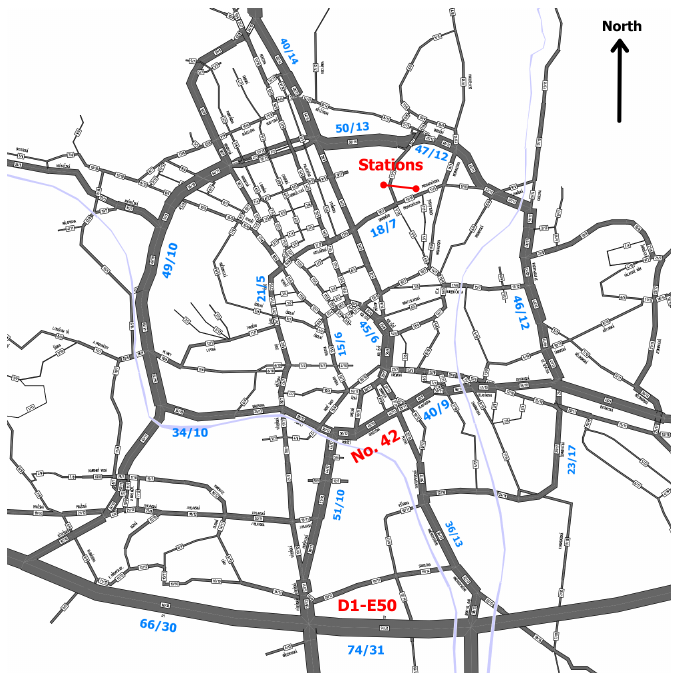
Figure 2. Traffic intensity in Brno for the year 2018